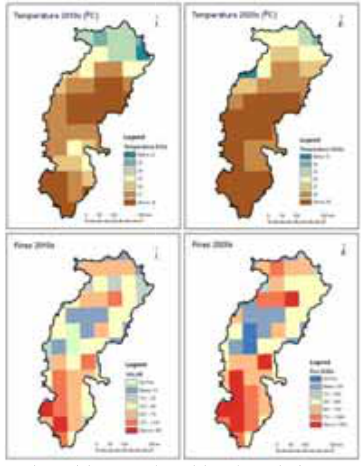
Figure 5: Fire vulnerable zone i